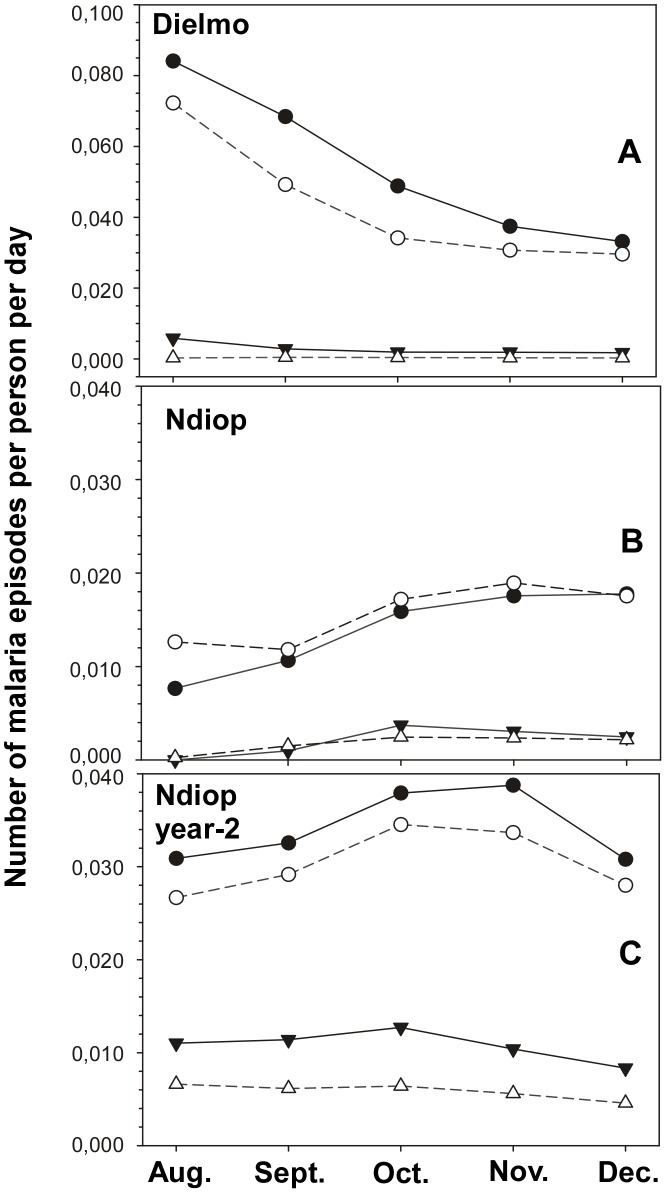
Association between anti-PfMSP5 IgG responses and cumulative incidence of clinical malaria episodes in different age groups.The cumulative monthly incidence of clinical attacks across the 5.5-month follow up was determined for individuals with dichotomized negative i.e. OD ratio ≤2 (filled symbols, solid lines) vs positive responders, i.e. OD ratio >2 (open symbols, dashed lines) against anti-PfMSP5 IgG for each cohort. Young individuals (circles) vs older (triangles) are shown for Dielmo-2002 (A: <7yo vs ≥7yo; EIR = 295.5), for Ndiop-2002 (B: <15yo vs ≥15yo; EIR = 17.9) and for Ndiop-2000 (C; EIR = 50.7).